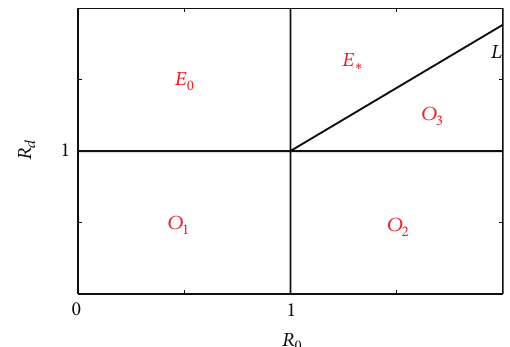
Figure 1: 𝑅 𝑑 in terms of 𝑅 0 . The region of 𝑂 1 , 𝑂 2 , and 𝑂 3 is the basin of attraction of equilibrium 𝑂 ; the region of 𝐸 0 is the basin of attraction of equilibrium 𝐸 0 ; the region of 𝐸 ∗ is the basin of attraction of equilibrium 𝐸 ∗ ; the line 𝐿 is 𝑅 𝑑 = 𝑅 1 = 1 + 𝜇(𝑚 + − 1)/𝑚𝛽(𝑚 + 𝜎 + 𝜇) 𝜇)(𝑚 + 𝜎)(𝑅 0